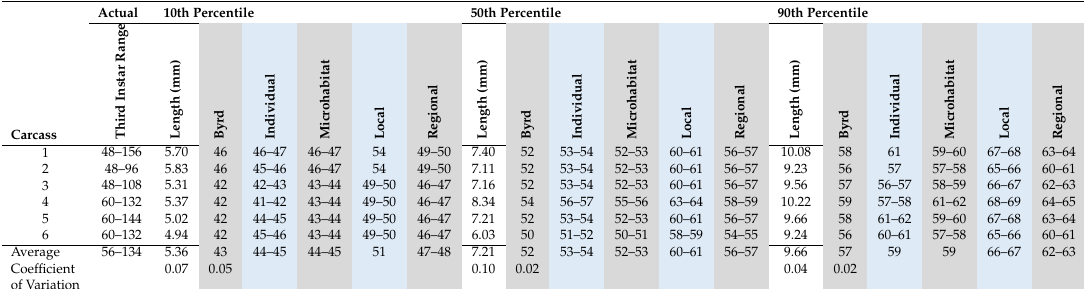
Table 5. Actual and estimated Cochliomyia macellaria post-colonization intervals (PCIs) calculated using 10th, 50th, and 90th percentile third instar lengths and each temperature source, with a minimum developmental threshold of 10 ◦ C. Min, med, and max represent the minimum, median, and maximum hourly value for each PCI. All time values represent hours. White areas represent actual values, while gray and blue areas represent estimated values from published development data and body lengths [30].